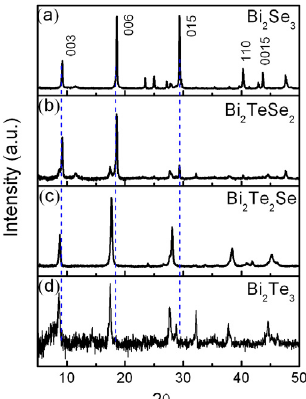
Figure 2. X-ray diffractometer (XRD) patterns of the as-grown four compounds (Bi 2 Te 3 , Bi 2 Te 2 Se, Bi 2 TeSe 2 and Bi 2 Se 3 ).